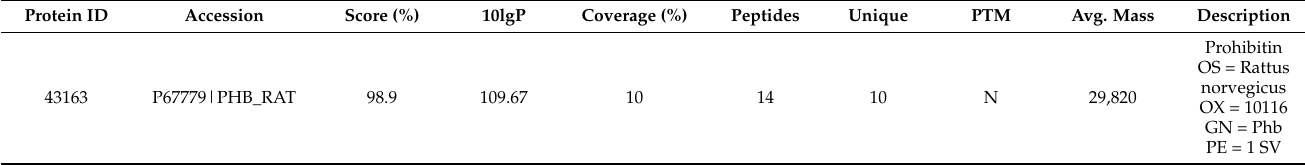
Table 1. Identification of 30 kDa protein in RHM by mass spectrometry as Prohibitin (PHB).